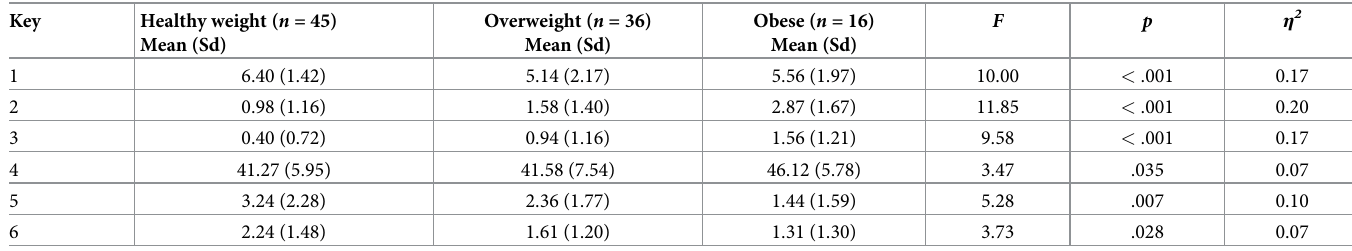
Table 10. Control group one-way ANOVA for BMI classification on main variables. Key Healthy weight ( n = 45) Mean (Sd)